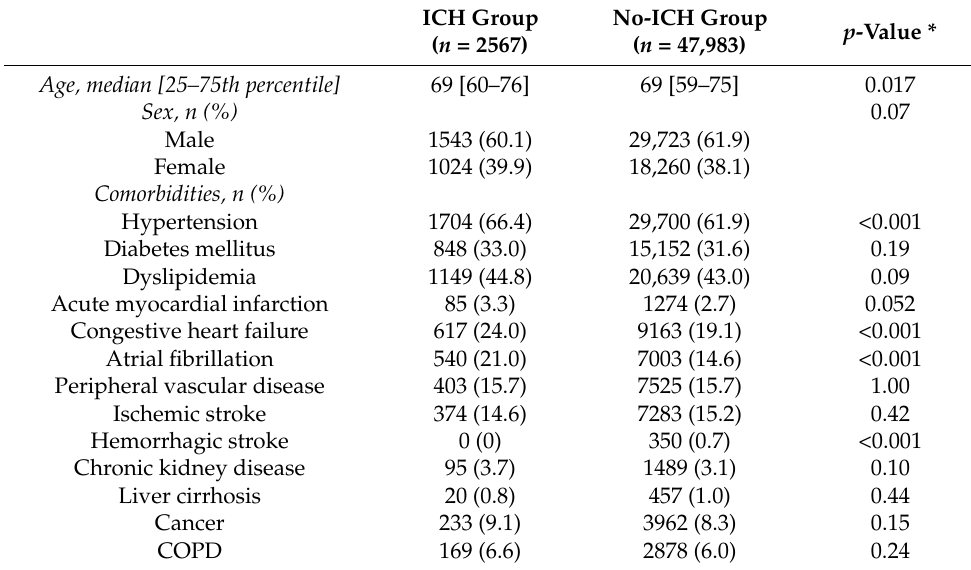
Table 1. Baseline characteristics of the study